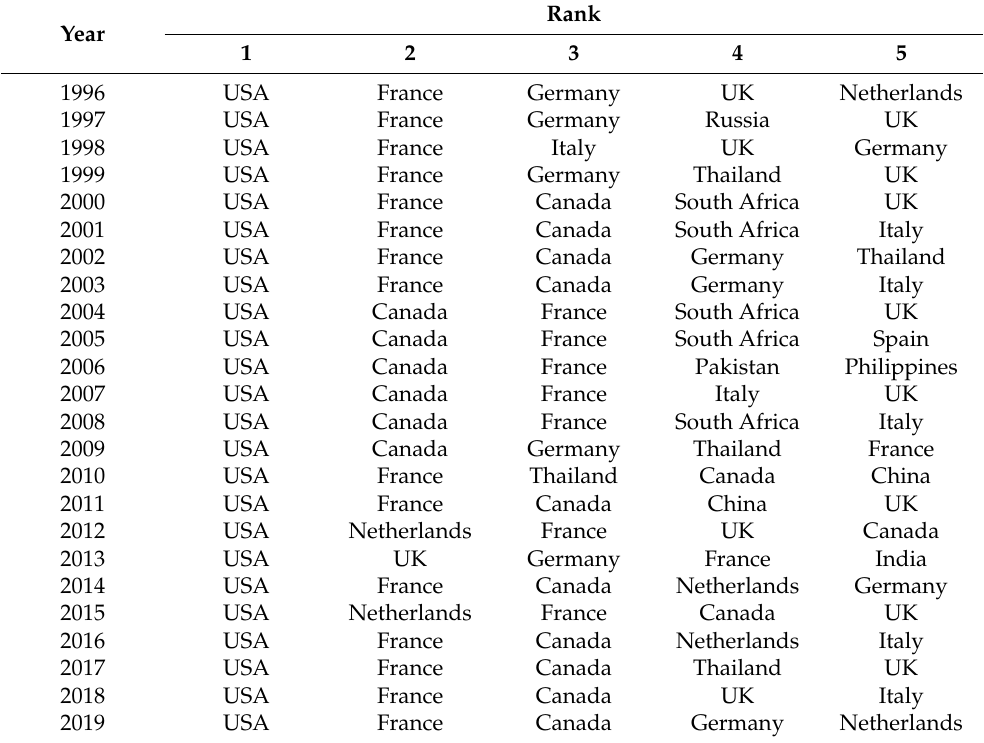
Table A1. The top 5 countries in betweenness centrality.